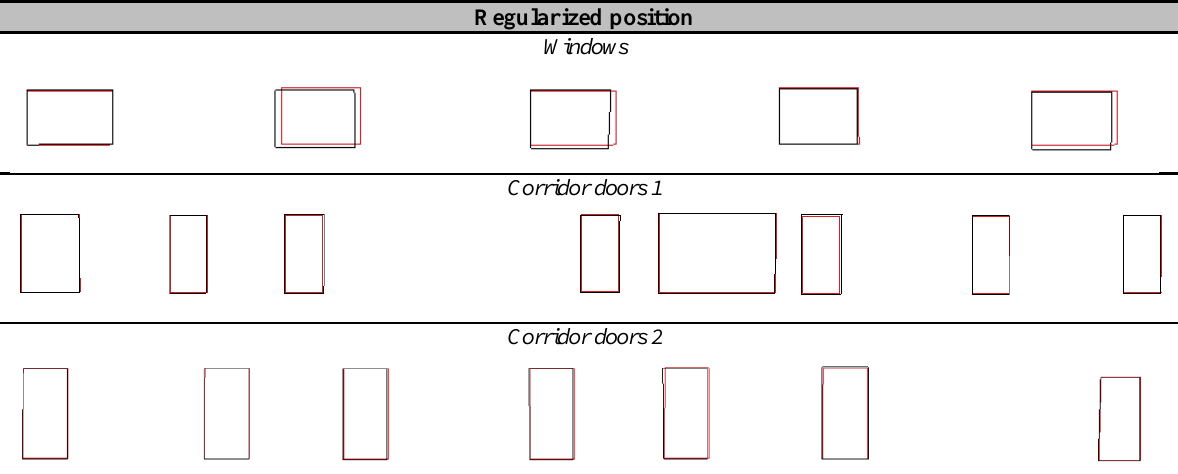
Figure 7. Regularization results: initial (black) and regularized (red) position of for the building features. Figure 8 shows the final reconstruction for the data sets used. It is worth to notice that all rooms have been successfully reconstructed and all doors and windows detected.